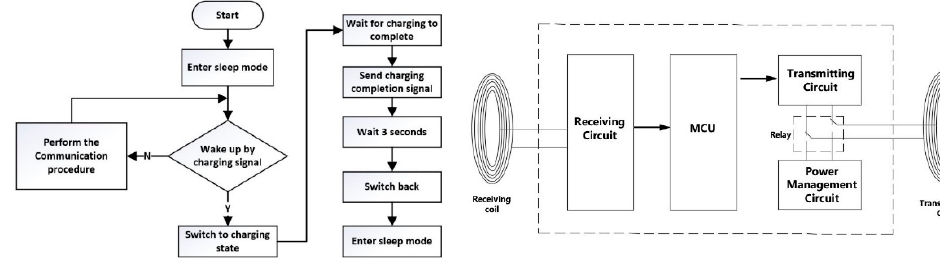
Figure 19. Power management logic.